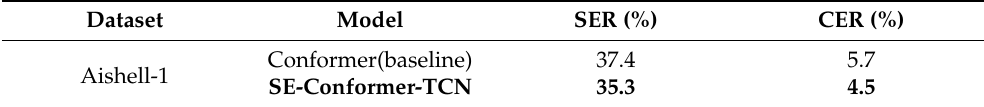
Table 4. Experimental results on dataset